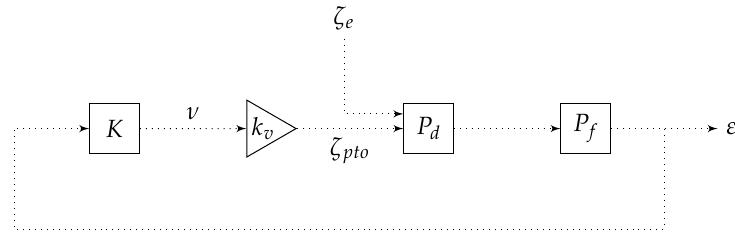
Figure 3. Simplified representation of the PTO simulator